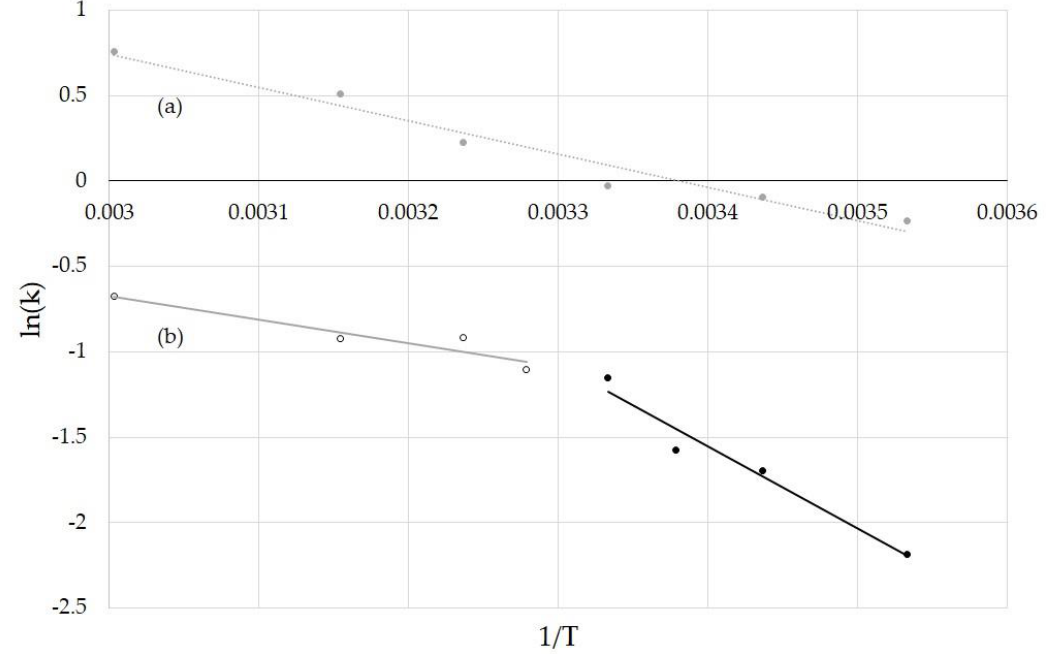
Figure 9. The dependence of ln(k) on the reciprocal temperature for ( a ) yttrium and ( b ) iron.